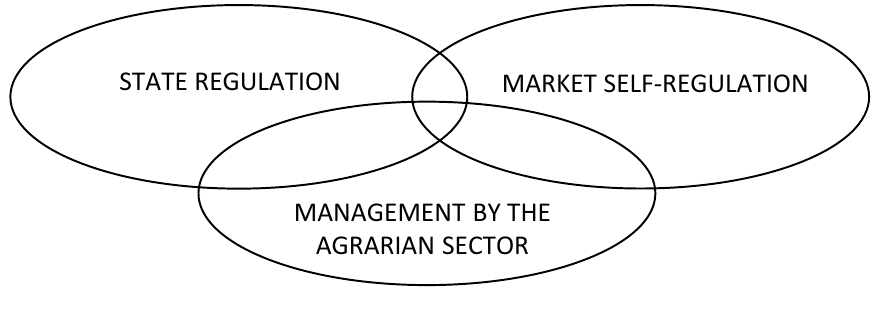
Figure 3. Interaction of management subjects of sustainability of agrarian sector